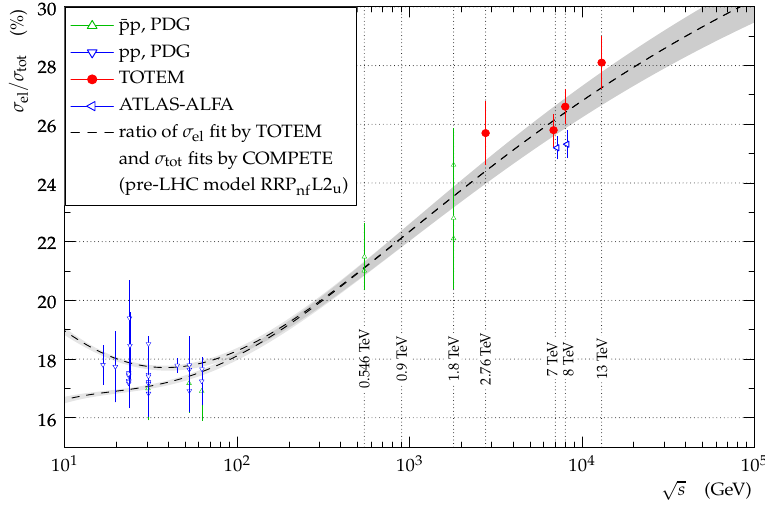
Fig. 2. The energy dependence of the ratio of the elastic to total proton- Figure 2. The energy dependence of the ratio of the elastic to total proton-proton cross sections proton cross sections [8].